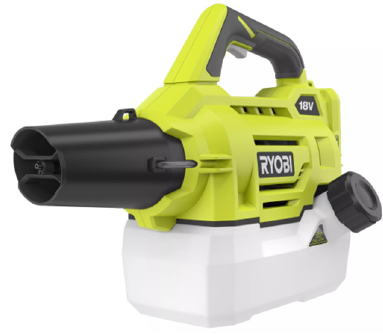
Figure 1. Device under test.